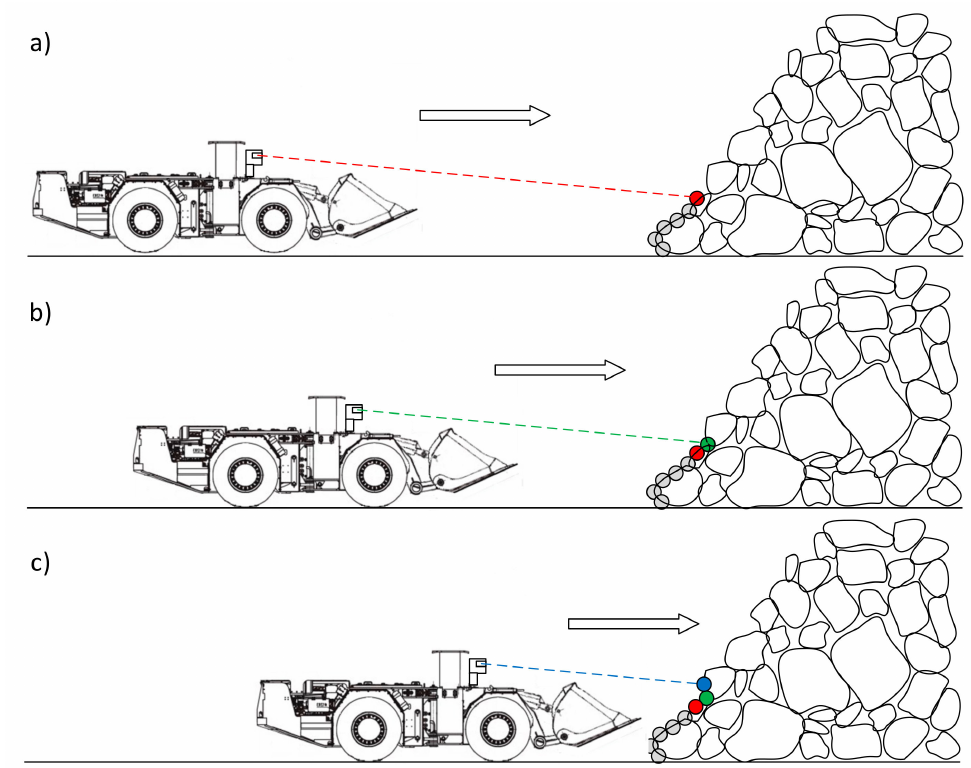
Figure 8. Rock pile reconstruction process through laser-scan integration. As the machine approaches the pile (images ( a – c )), the new laser scans are merged with the previous ones using the computed odometry. A slightly tilted LIDAR is used for this